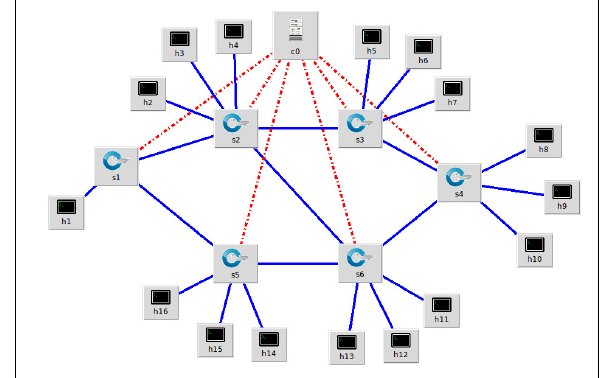
Figure 4. Test network architecture - Mininet